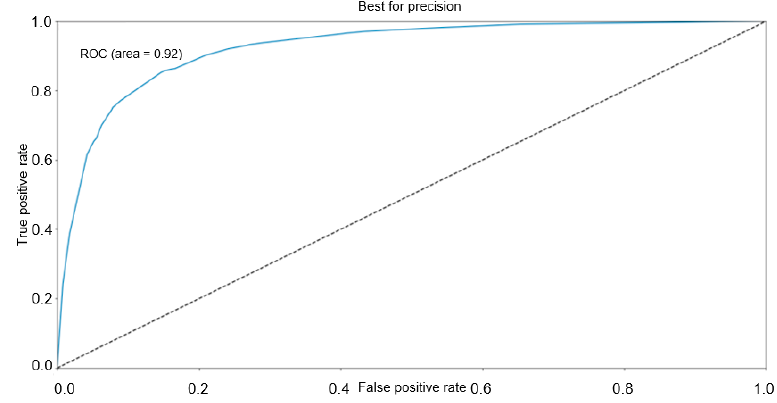
Figure 3. ROC for the classification model.